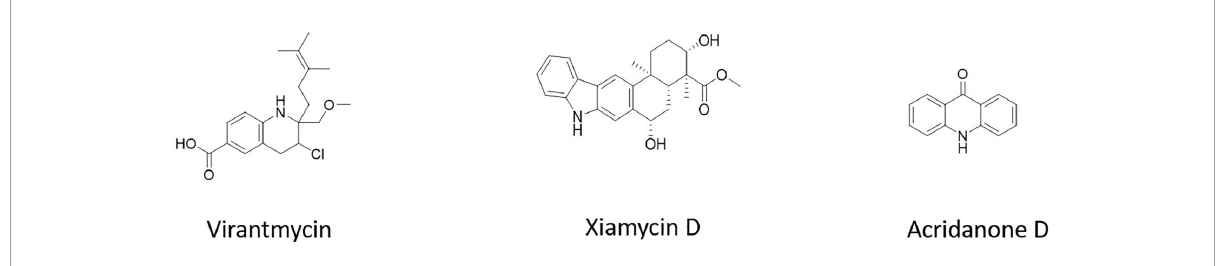
FIGURE5 Antiviral compounds from Streptomyces